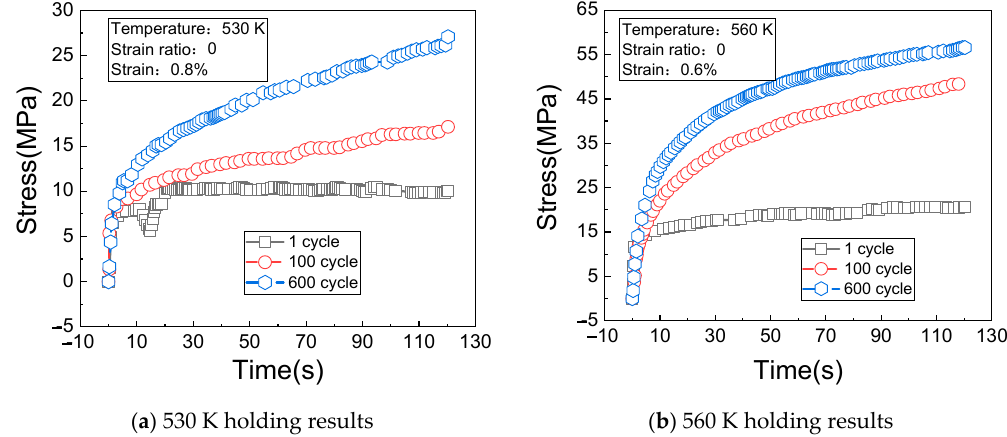
Figure 12. Stress relaxation results of holding at 530 K and 560 K. ( a ) 530 K holding results; ( b ) 560 K holding results.